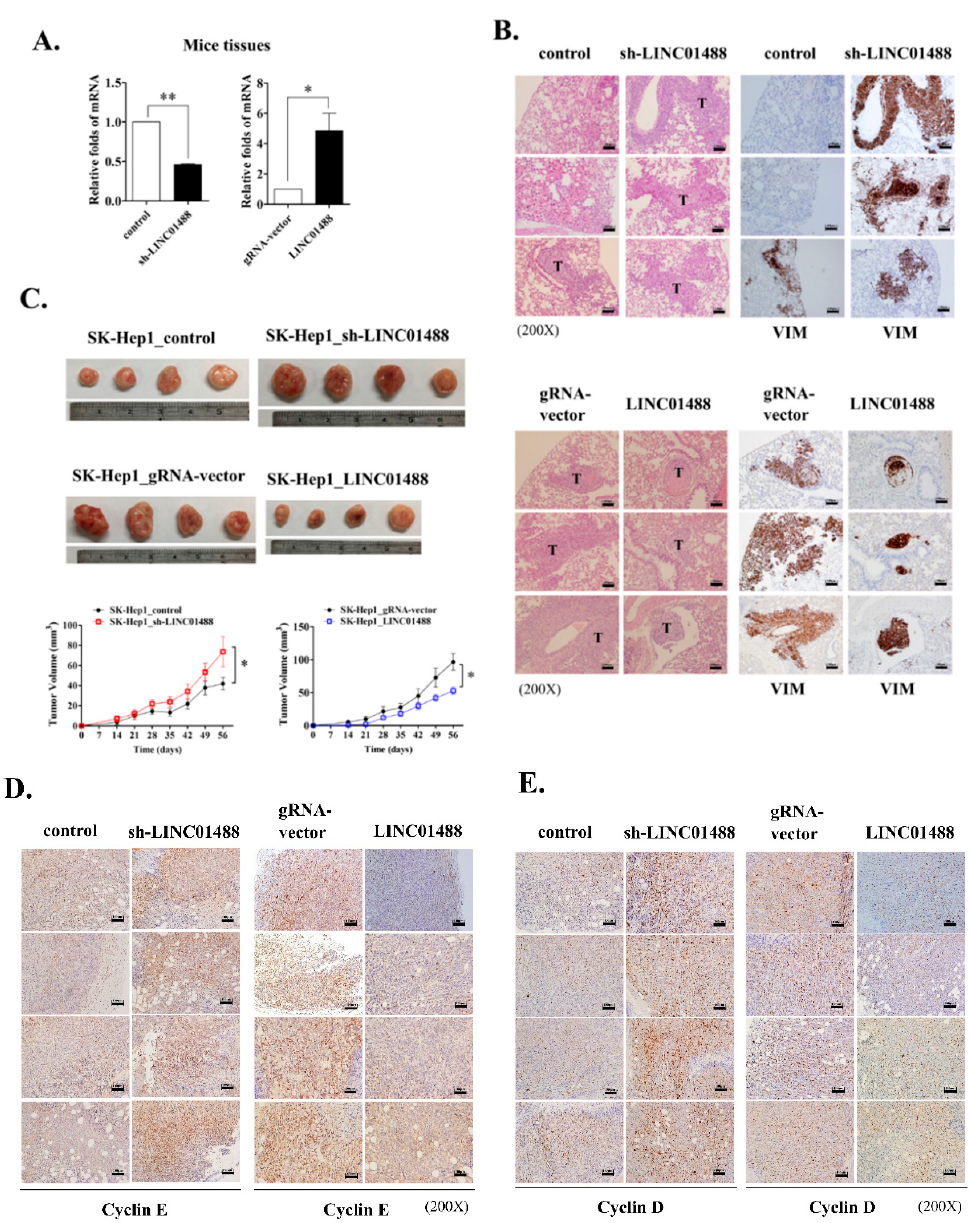
Figure 7. LINC01488 suppresses metastasis and tumorigenesis of hepatoma cells in vivo. Mice were injected with control, LINC01488-depleted or LINC01488-overexpressing SK-Hep1 or Hep3B cells either subcutaneously or via the tail vein. ( A ) qRT-PCR analysis of LINC01488 mRNA levels in lung tissue of mice. ( B ) Immunohistochemical analysis of vimentin protein levels in lung tissue of mice containing LINC01488-depleted or -overexpressing cells. ( n = 3 / group). ( C ) Tumor sizes from LINC01488-depleted or -overexpressing cells. Mice were subcutaneously injected with tumor cells for 8 weeks. ( D ) Immunohistochemical analysis of cyclin E and ( E ) cyclin D protein levels in lung tissue of mice injected subcutaneously with the indicated cells. ( n = 4 / group). Data are presented as means ± SD (* p < 0.05; ** p < 0.01). Scale bar: 100 µ m.